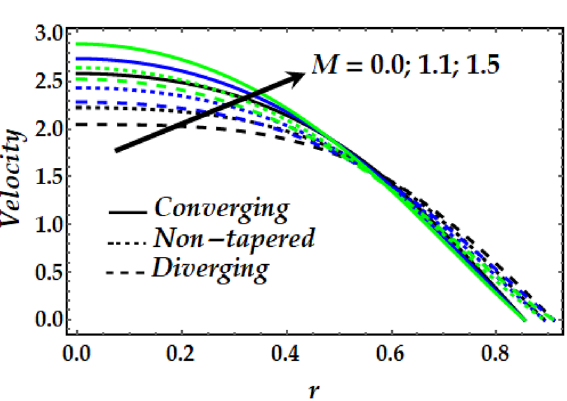
Figure 4. Velocity profile against distinct values of M